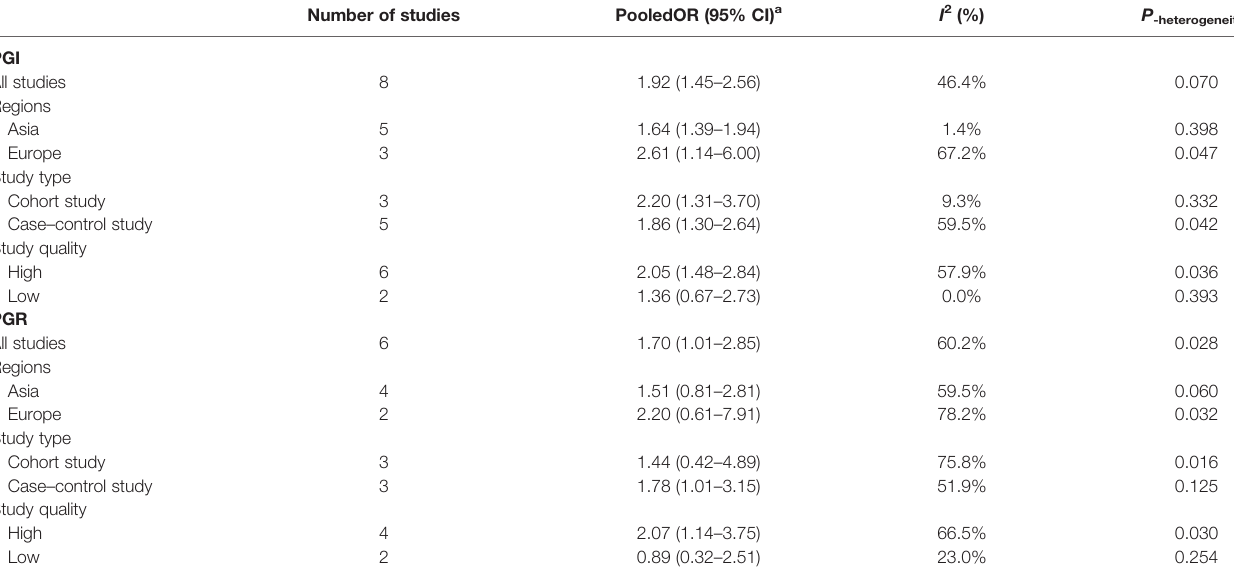
TABLE 2 | Meta-analysis on association of esophageal squamous cell carcinoma risk with PGI and